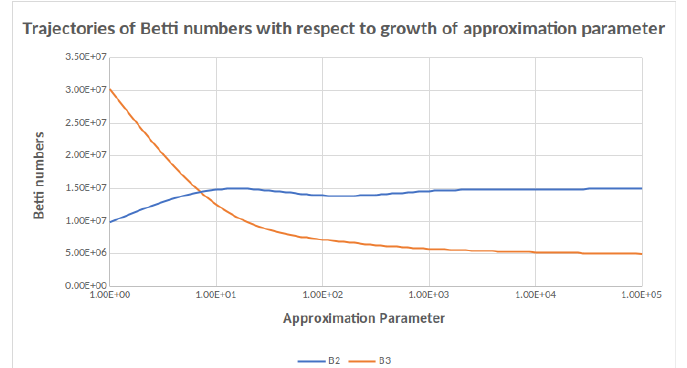
Figure 1. Trajectories of β 2 and β 3 as a function of the approximation parameter. A change in order of magnitude in the approximation parameter results in a small change in the Betti number computed.